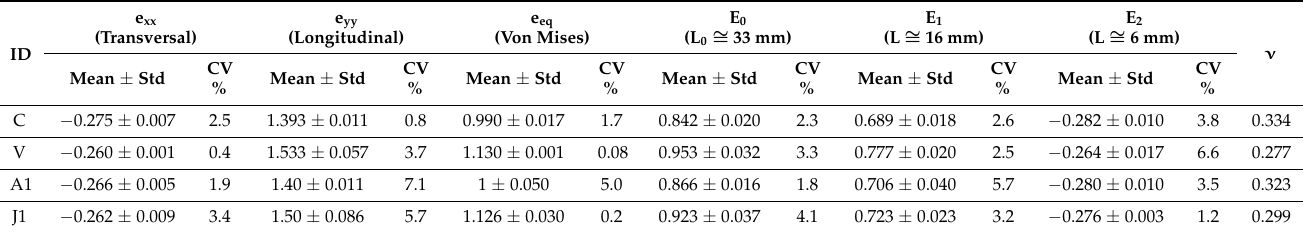
Table A3. The most significant soft tissue-mimicking polymers, average highest values computed for e xx , e yy , and e eq . The Poisson’s ratios ( ν ) reported were calculated using the virtual extensometers E 2 and E 0 positioned on the dog-bone specimen surface. Mean ± standard deviation (std) values, and Coefficient of variation (CV%) are reported. The negative sign ( − ) in the values reported means material